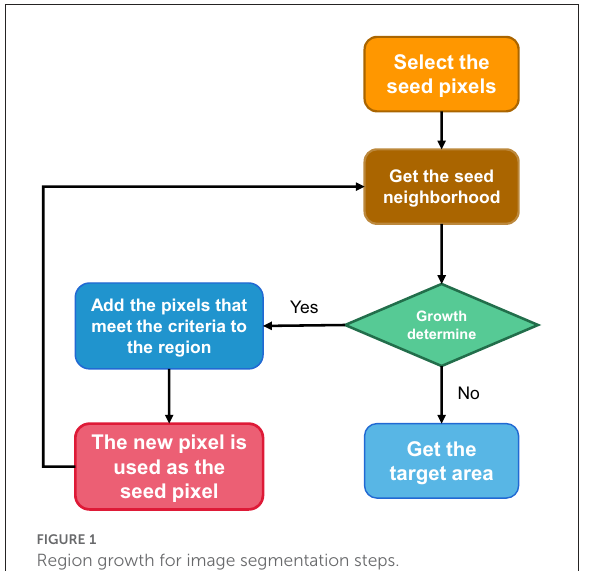
FIGURE1 Region growth for image segmentation steps.